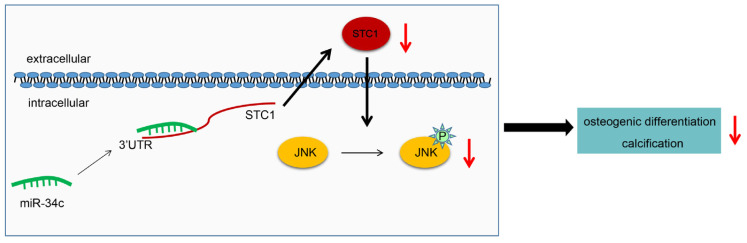
MiR-34c binds to STC1 to inhibit the activation of the JNK pathway, resulting in the suppression of the osteogenic differentiation and calcification degree in VICs.